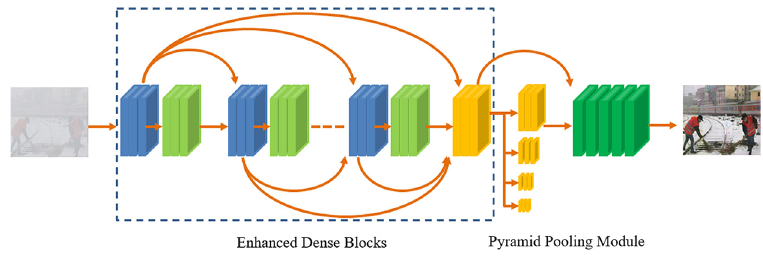
Figure 2. The architecture of Enhanced Densely Dehazing Network